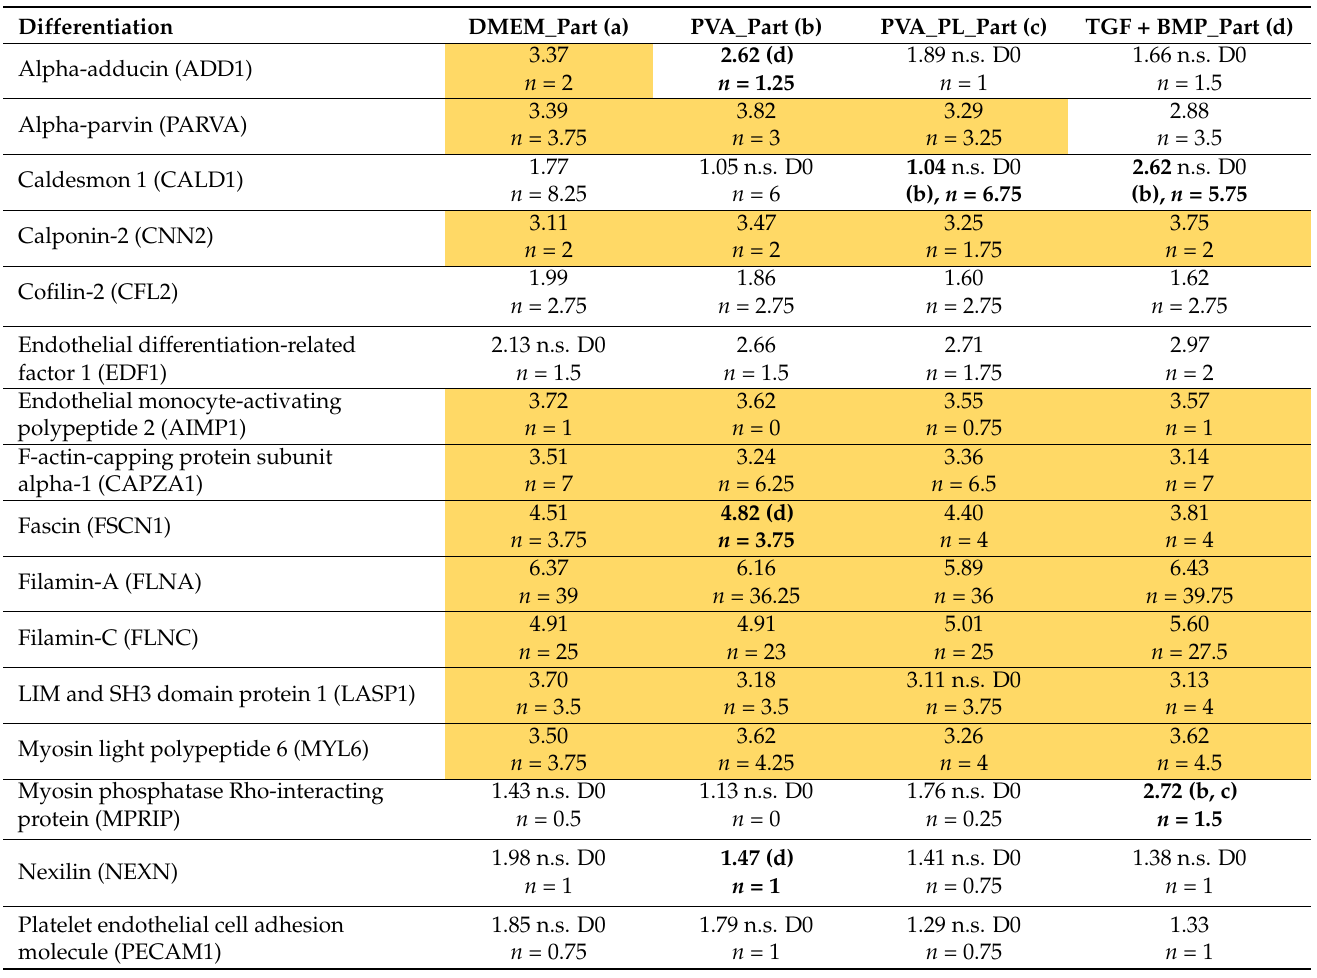
Table 2. Proteins involved in cell differentiation produced by ASCs and ECs in DMEM_part,